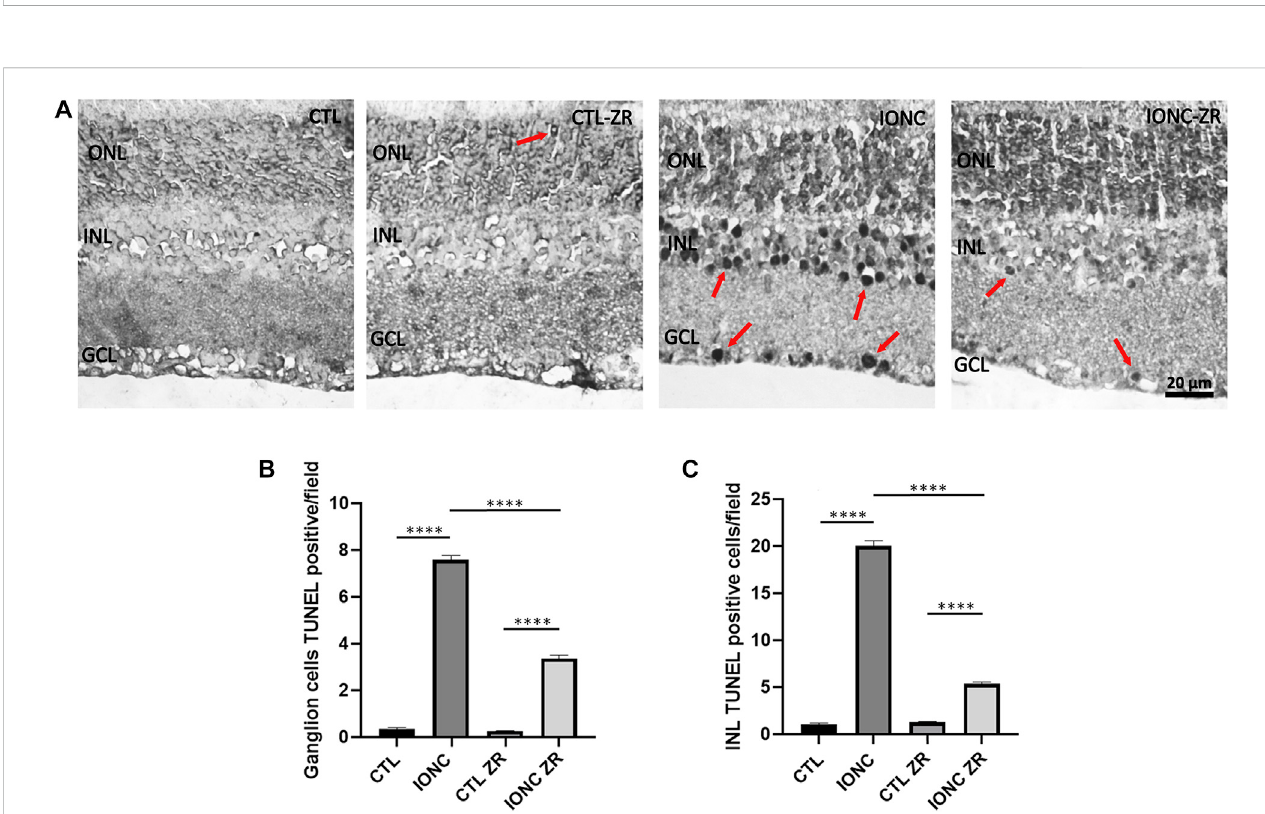
FIGURE 5 TUNEL positive cells on the four experimental groups. Representative images of retinas from animals in the four experimental groups taken 6 days after surgery (A) .Thenuclearlayersoftheretinaareindicated:outernuclearlayer(ONL),innernuclearlayer(INL),andganglioncelllayer(GCL).TUNELpositivecells (arrows)werefound mainlyintheGCL andtheINL.Sizebar= 20 μ m.Quanti fi cationoftheresults fortheGCL (B) and theINL (C) isshownas histograms.Bars represent the mean ± SD of all animals ( n = 18 fi elds per experimental group). Asterisks represent statistically signi fi cant differences (ANOVA). ****: p <